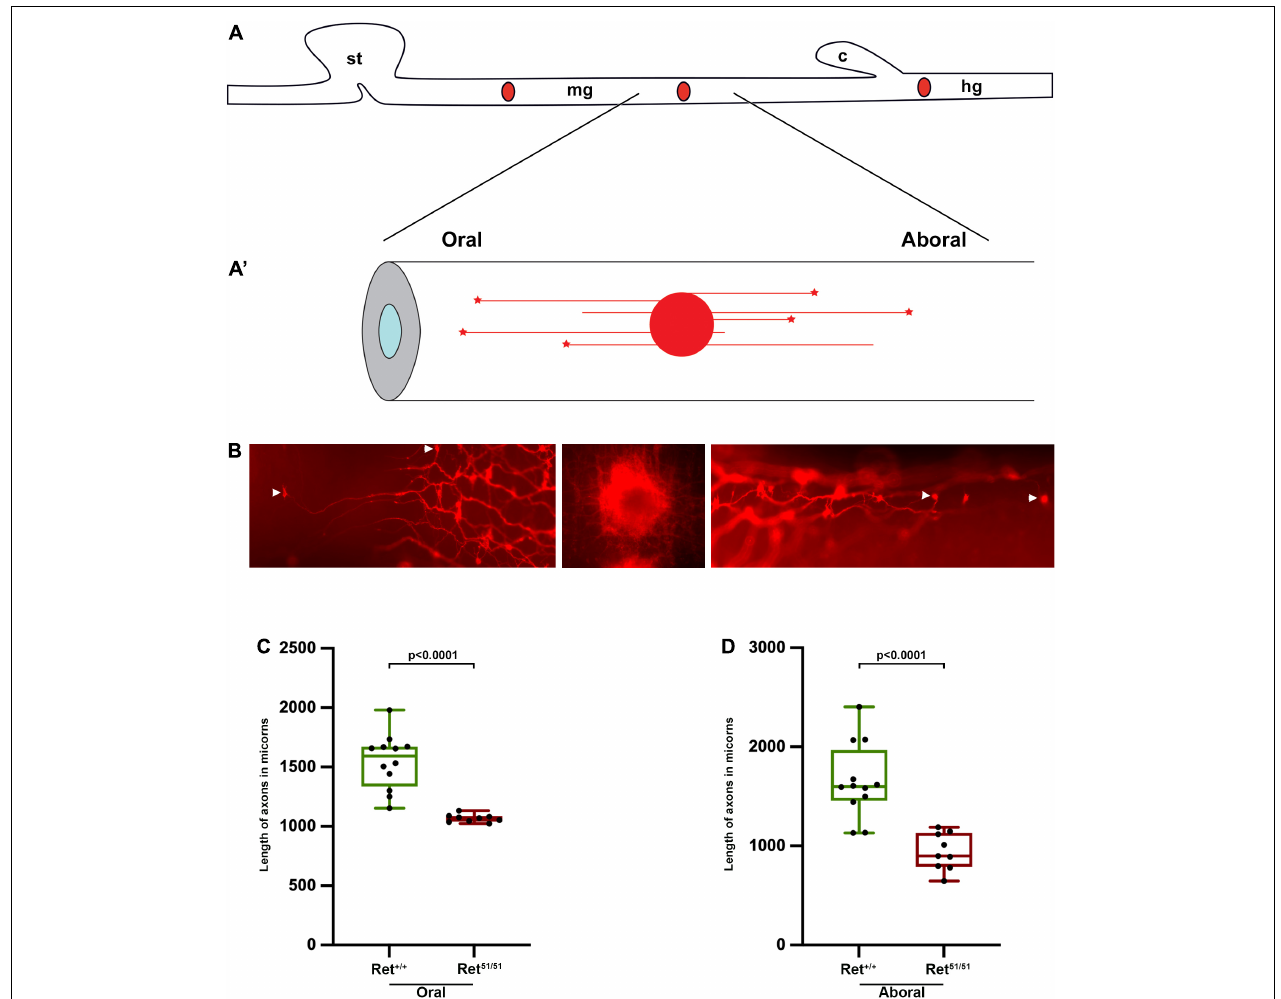
FIGURE 5 | Reduced neurite length of Ret 51 / 51 enteric neurons (A,A’) Schematic representation of DiI labelling and retrograde DiI labelling of individual enteric neurons and their processes. (B) Fluorescent images of DiI labelled enteric neurons in the gut of perinatal animals. Middle panel shows the site of DiI crystal, left and right panels show individually labelled oral and aboral enteric neurons respectively. Arrowheads point to the cell body showing length of processes of control ( Ret + / + ) and Ret 51 / 51 orally (C) and aborally projecting (D) neurons in the gut of perinatal animals. P1 pups ( n = 6 for each genotype) from 4 litters were used for analysis; 9–12 axons were measured in the oral and aboral directions. Statistical analysis performed by Welch’s t